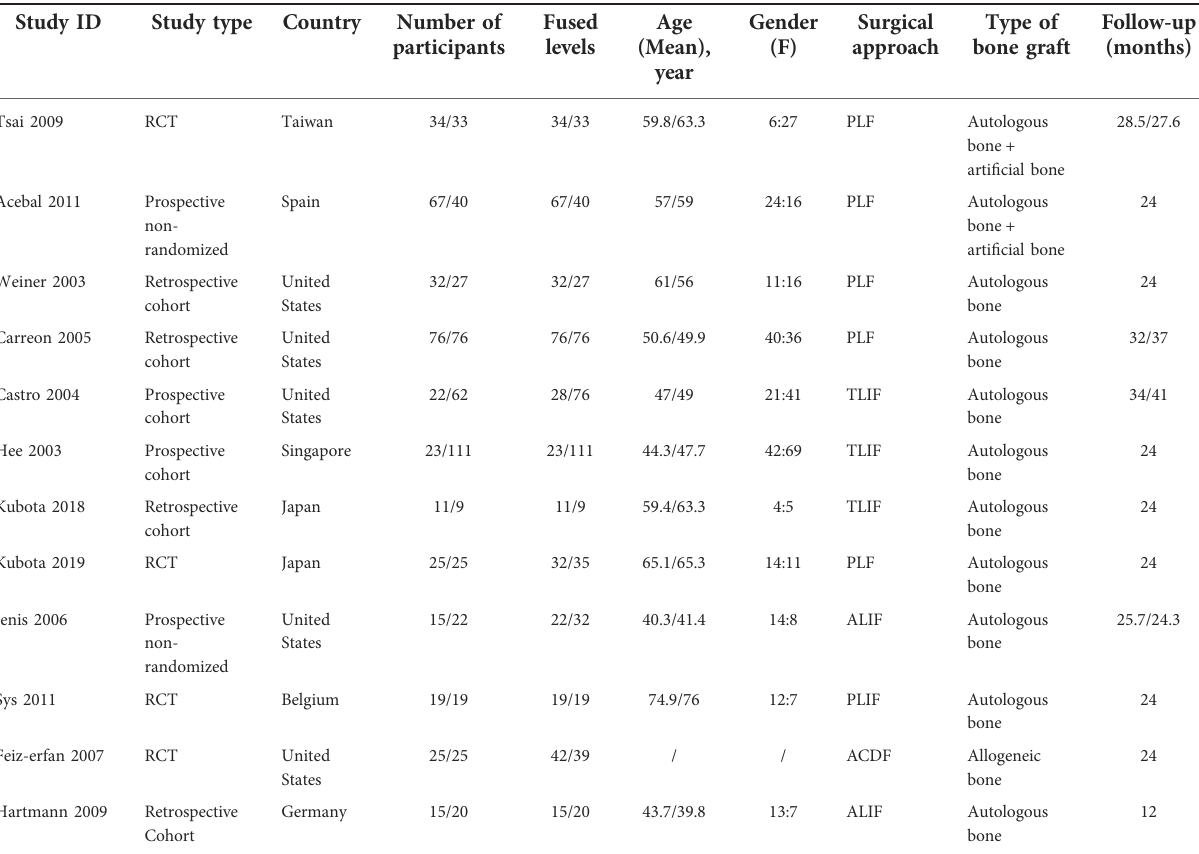
TABLE 1 Demographic characteristics of the included studies.